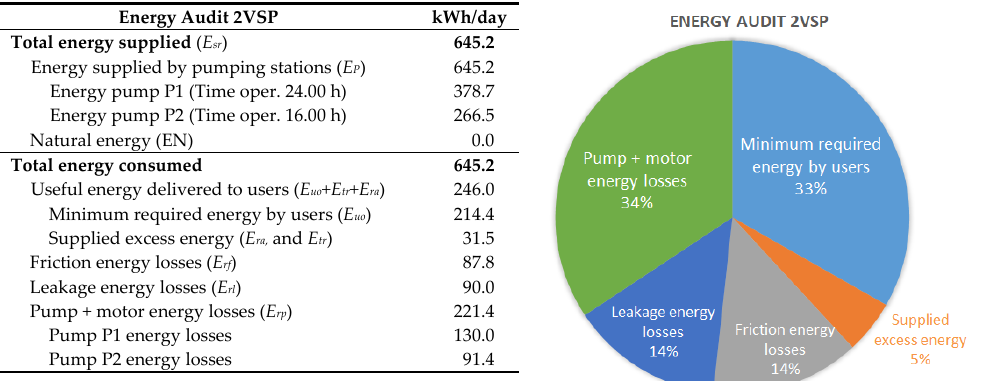
Table 2. Minimum required pump performances for ESOB 1450 pumps [16].